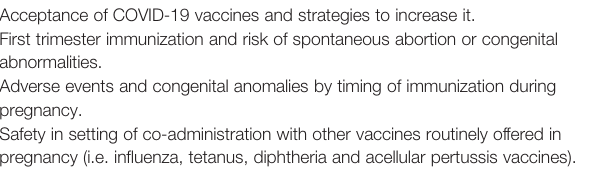
TABLE 3 | Consensus on priorities for future research related to ethics and safety of immunization against SARS-CoV-2 in pregnancy. Acceptance of COVID-19 vaccines and strategies to increase it. First trimester immunization and risk of spontaneous abortion or congenital abnormalities. Adverse events and congenital anomalies by timing of immunization during pregnancy. Safety in setting of co-administration with other vaccines routinely offered in pregnancy (i.e. in fl uenza, tetanus, diphtheria and acellular